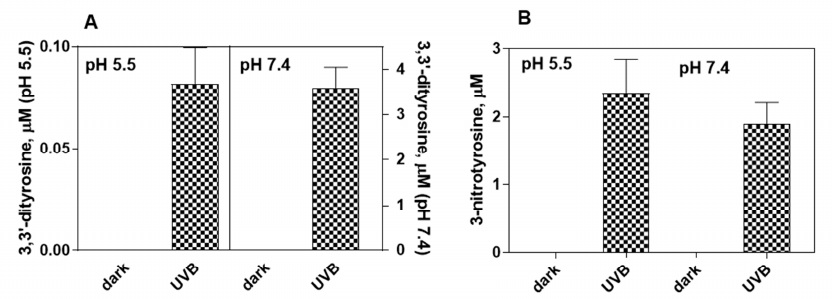
Figure 3. UVB-induced photooxidation/photonitration of tyrosine. A reaction mix containing 1 mM tyrosine in 0.2 M K-phosphate buffer at pH 5.5 or pH 7.4, 0.1 mM DTPA, 10 mM K-nitrite is exposed to UVB radiation. After 30 min of exposure, the reaction is stopped by placing the mixture in the dark and the solution is analyzed by HPLC, to determine the formation of 3,3’-dityrosine ( A ) and 3-nitrotyrosine ( B ), as reported in Materials and Methods. Controls in the dark correspond to the unexposed solution.